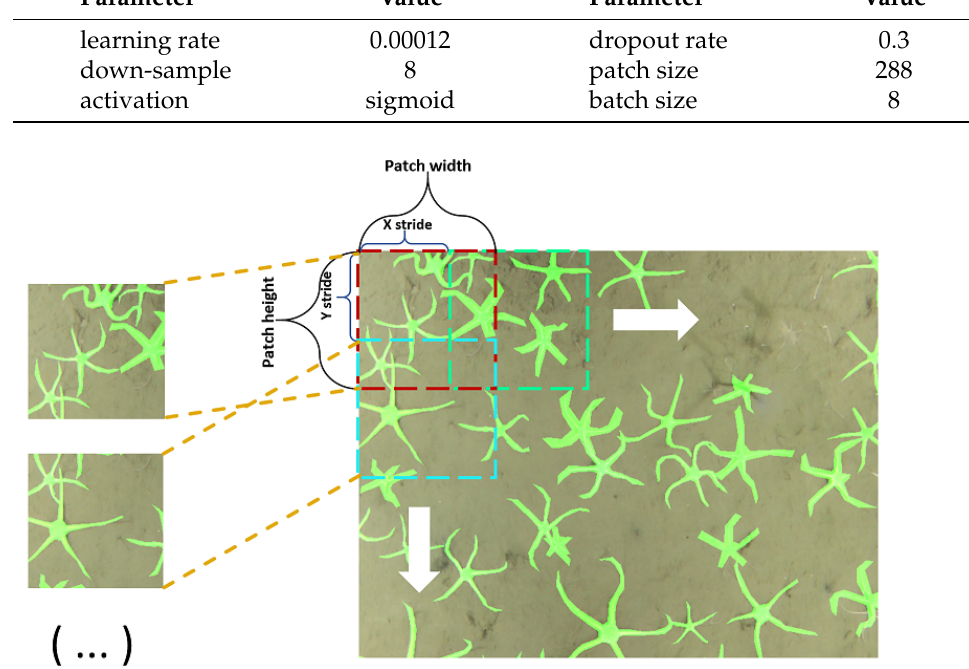
Figure 5. A generalized overview of sliding window approach to slice an input image into patches for training